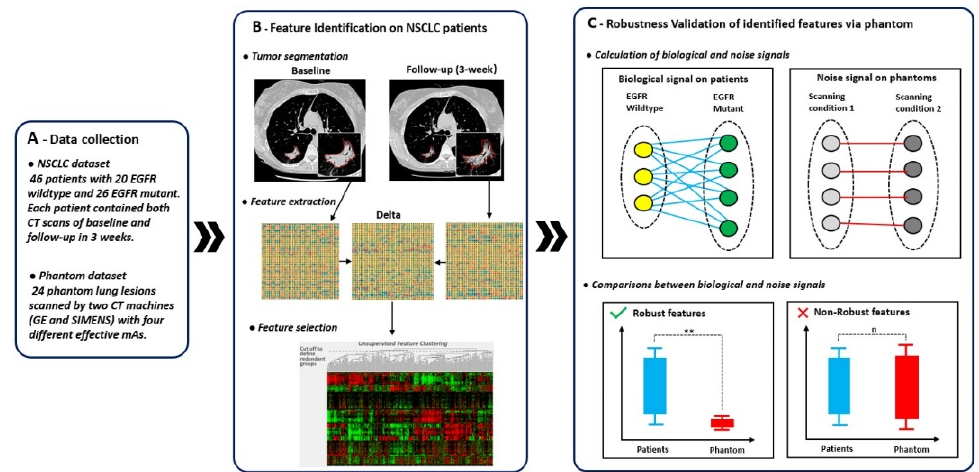
Figure 1. Overview of study design. The overall study design consisted of three parts: ( A ) data collection, ( B ) feature identification on non-small cell lung cancer (NSCLC) patients, and ( C ) robustness validation of identified features via phantoms. In ( C ), lines between elements represented absolute difference of feature value between two elements.